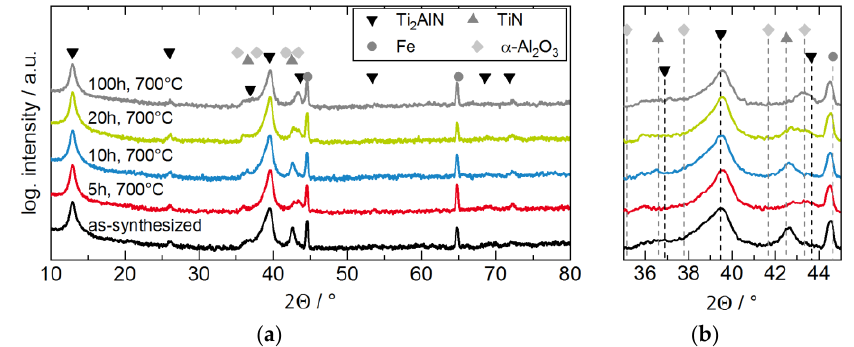
Figure 2. XRD diffractograms of as-synthesized and oxidized Ti 2 AlN coatings on ferritic steel Figure 2. XRD di ff ractograms of as-synthesized and oxidized Ti 2 AlN coatings on ferritic steel samples: